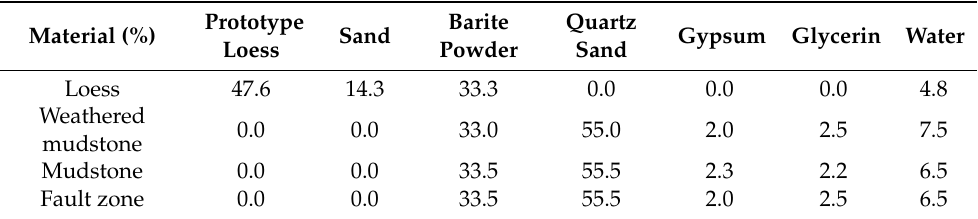
in mixing ratio test. mixing ratio test. Table 3. Mixture ratios of each similarity material [6]. Table 3. Mixture ratios of each similarity material [6].